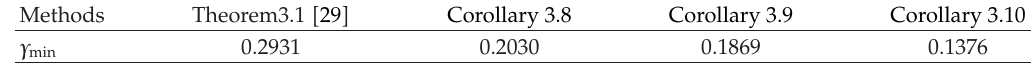
Table 1: Minimum index γ for di ff erent